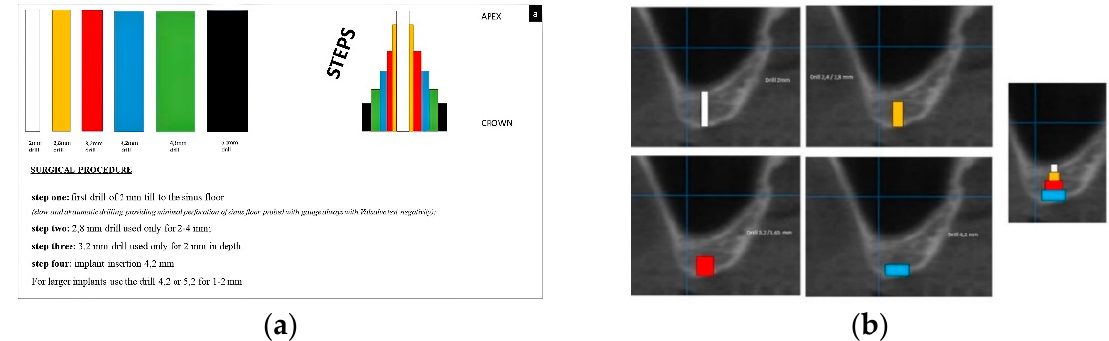
Figure 1. ( a , b ) Schematic description of the surgical technique allowing the formations of steps after drilling ( a ); as an example, the scheme is superimposed on a cone beam computed tomogra ‐ phy (CBCT) of an atrophic posterior maxilla ( b ).